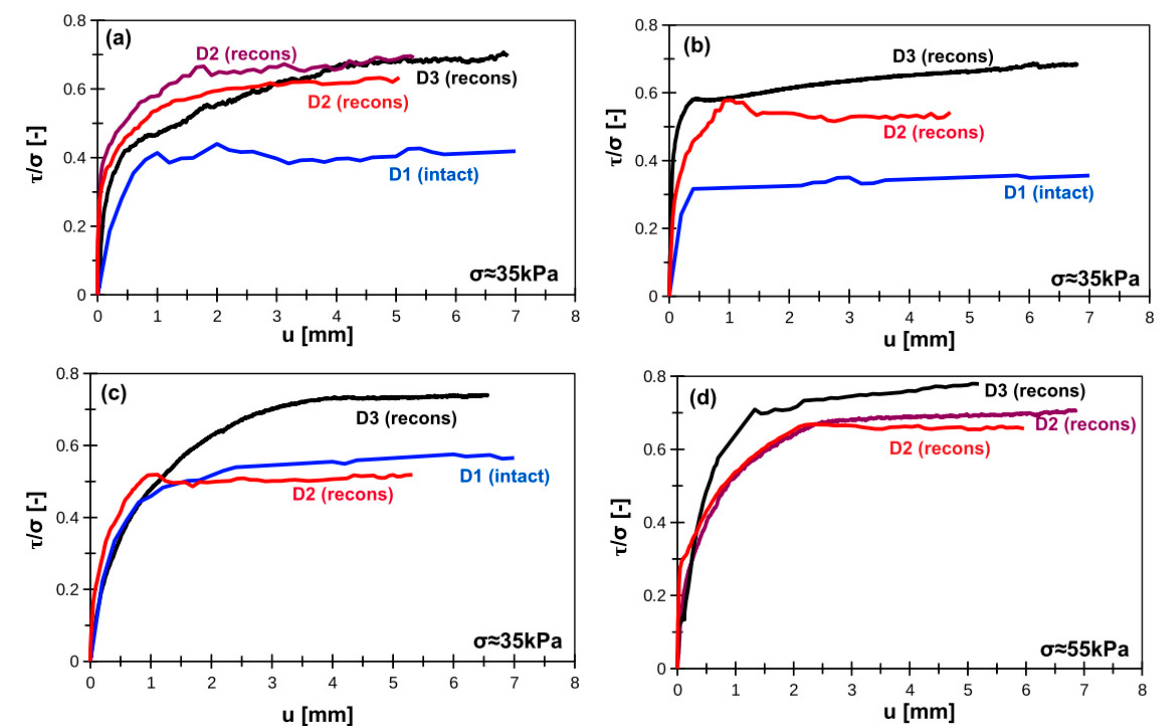
Figure 2. Normalized smooth concrete–soil interface shear strength for ( a ) silty loam, ( b ) organic clay, ( c ) peat, ( d ) organic silt. Note: D1, D2, D3 indicate device type; intact = intact sample, recons = reconstituted sample.